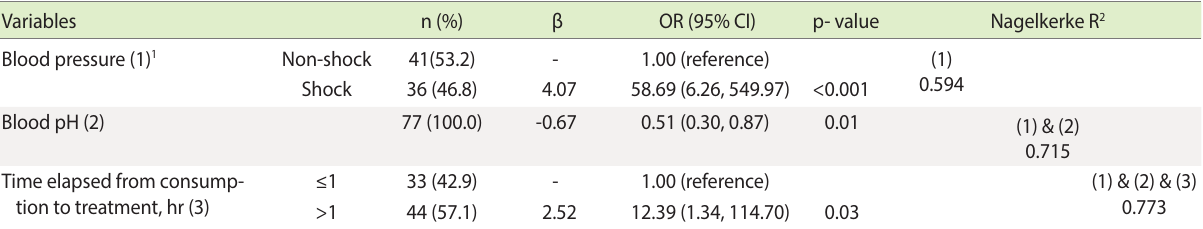
Table 3. Multivariate logistic regression analysis for factors related to mortality and their predictive power in patients with ALP